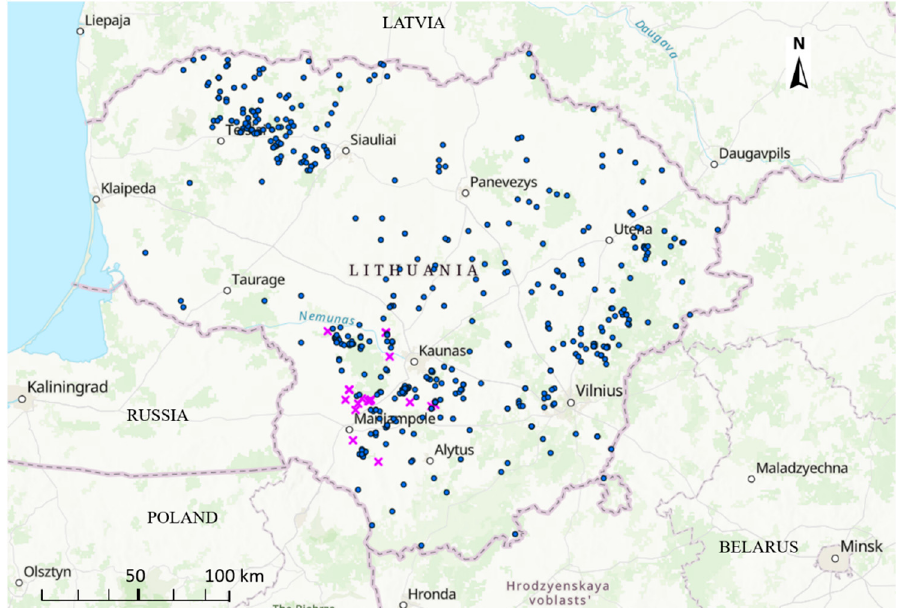
Figure 1. Spatial distribution of African swine fever outbreaks in domestic pigs (pink crosses) and wild boars (blue circles) in Lithuania in